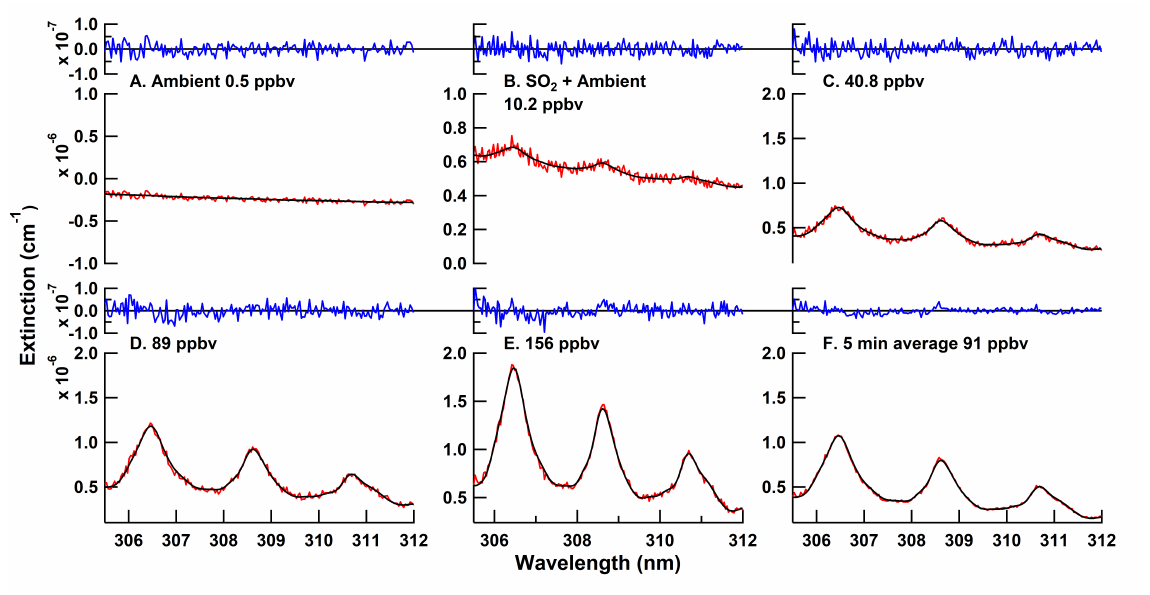
Figure 5. Fits of Equation (3) (black) relative to the measured extinction (red) in the lower portion of each panel. The difference of the black and red is shown on the upper axis for each panel in blue.